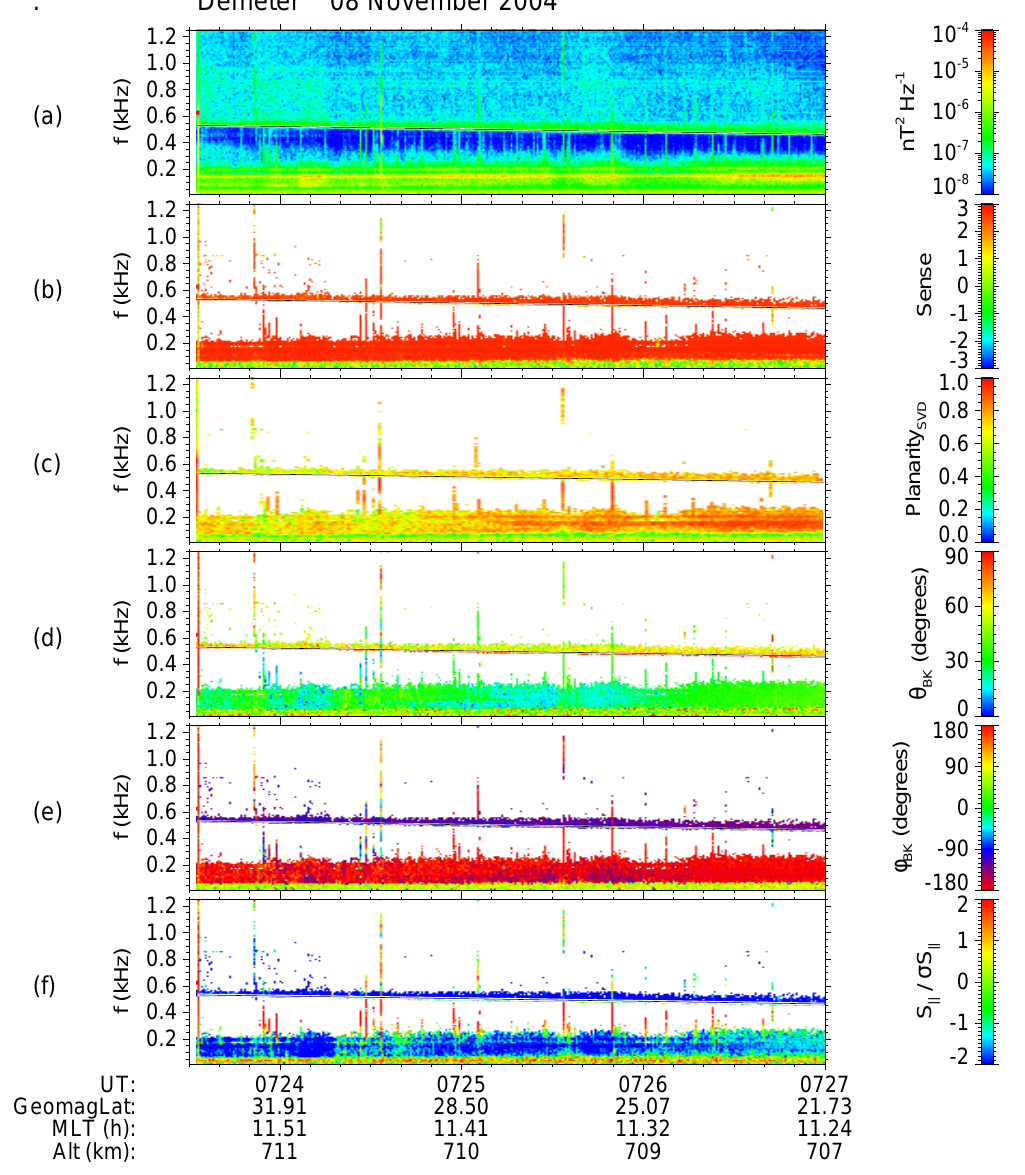
Fig. 9. Wave analysis of the event 2. (a) spectrogram of one magnetic component, (b) sense of polarization, (c) planarity, (d) and (e) polar and azimuthal angles of the wave vector with the Earth’s magnetic field B 0 , (f) projection of the Poynting vector onto B 0 (see text for explanation). The geophysical parameters at the bottom are the Universal Time (UT), the geomagnetic latitude, the Magnetic Local Time (MLT) and the